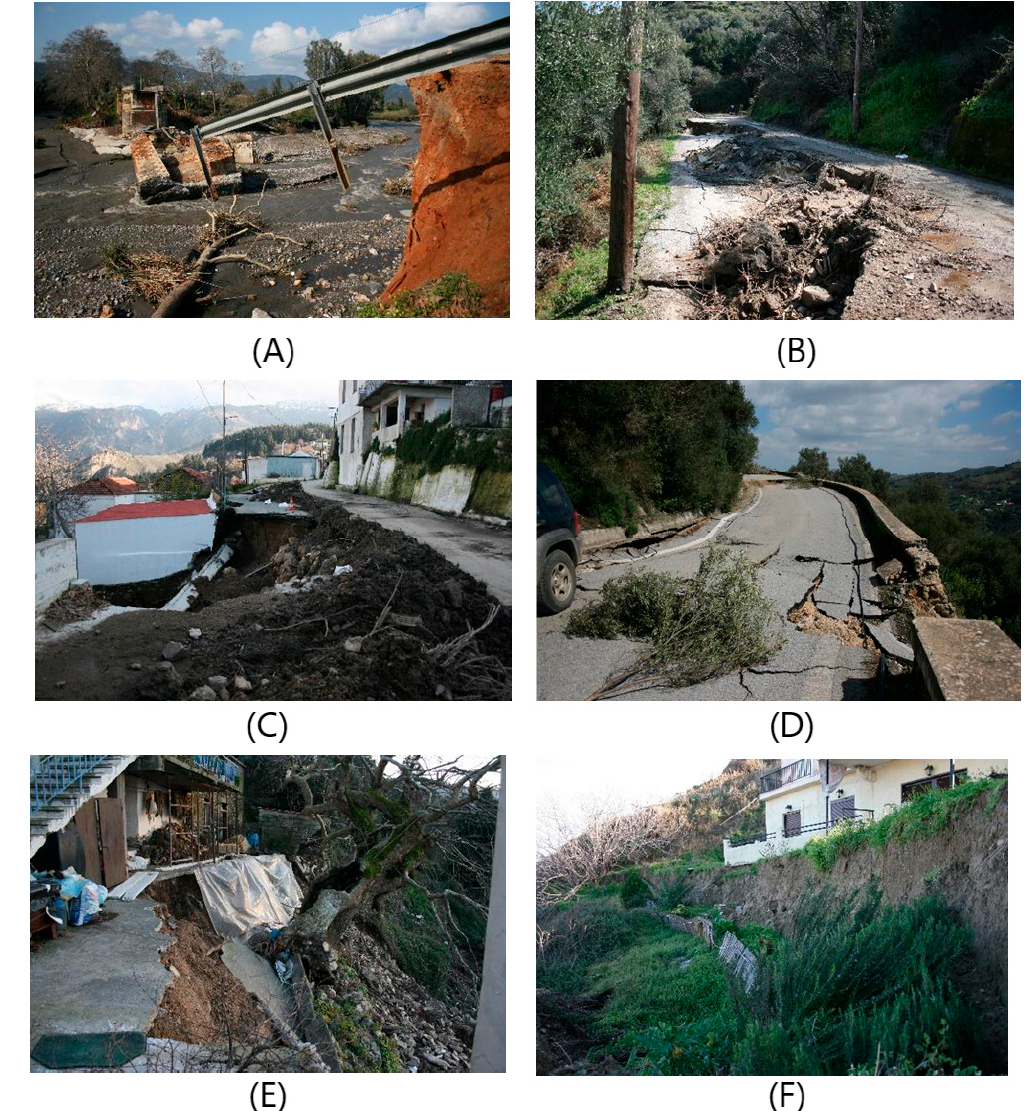
Figure 7. Impact of main landslide events: ( A ) an old bridge over Keritis river damaged by mud flow, ( B ) road embankment failure along the secondary road net to Giannikiana, ( C ) rotational slide due to excessive precipitation events along the Chania–Omalos provincial road, Lakki village, ( D ) the stability of the road net to Fotakado affected by rotational slide, ( E ) the local road net and houses in Platanes village, Palea Roumata, affected by mud flow, and ( F ) translation slide in the weathered mantle of Neogene formations in Kato Stalos village [36,37].